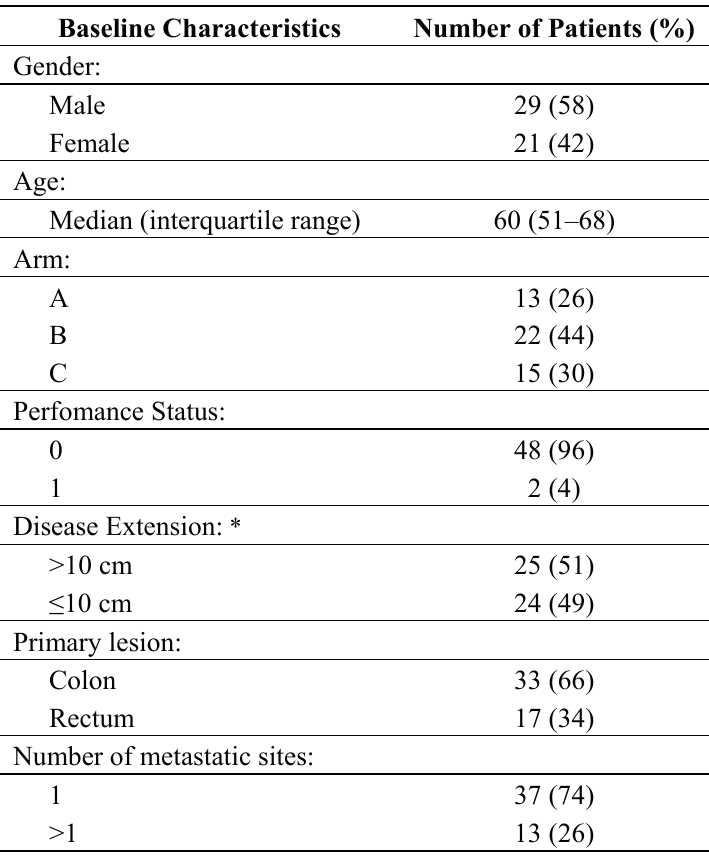
Table 1. Patients characteristics at baseline.